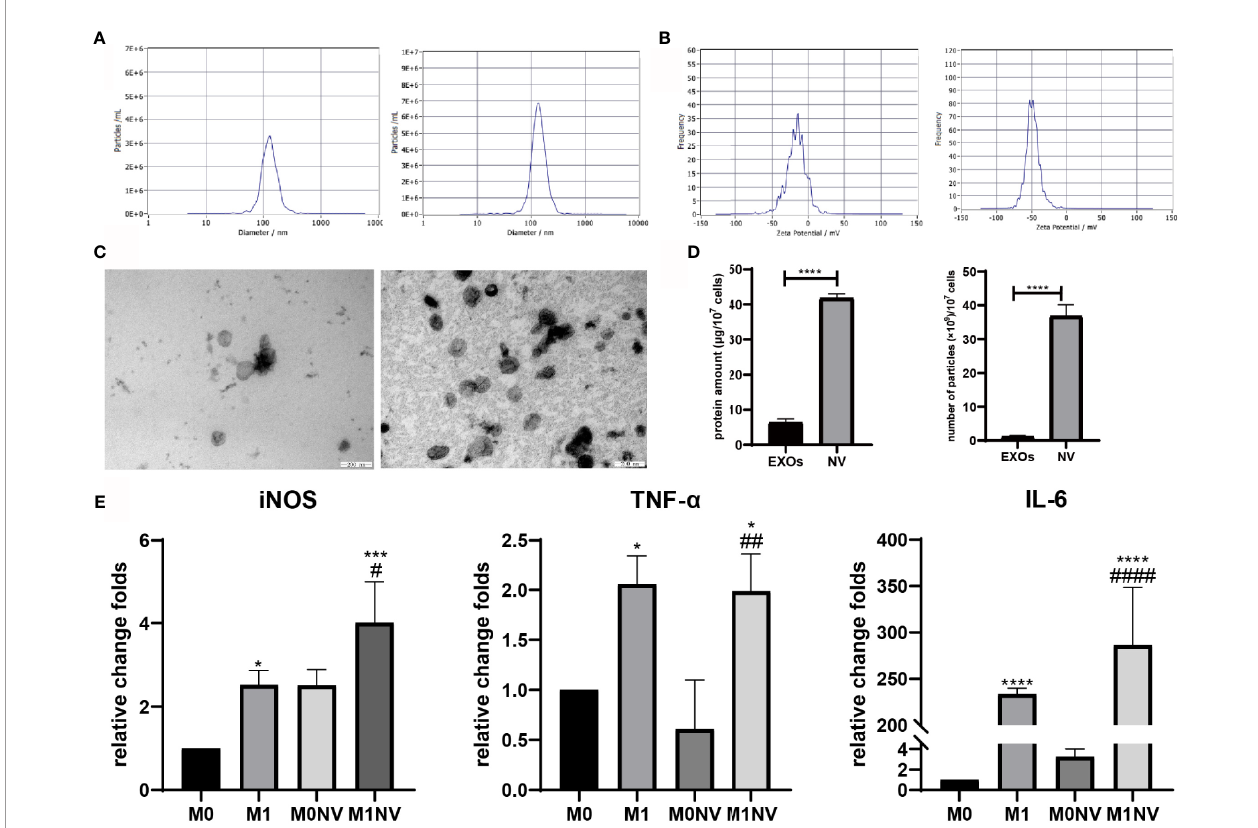
FIGURE 1 | Characteristics of nanovesicles. (A) Diameter of exosomes (left) and NVs right). (B) Zeta potential of exosomes (left) and NVs (right). (C) Morphology of exosomes (left) and NVs (right). Scale bar =200nm. (D) Protein amount and particles of exosomes or NVs derived from10 7 cells. (E) qRT-PCR revealed that M1NVs contained more mRNA of pro-in fl ammatory factors and M1 macrophage markers, indicating that M1NVs could effectively retain the functional characteristics of M1 cells. (*, ***, ****P < 0.05, P < 0.001. P < 0.0001 when compared to M0. # , ## , #### P < 0.05, P < 0.01, P < 0.0001 when compared to